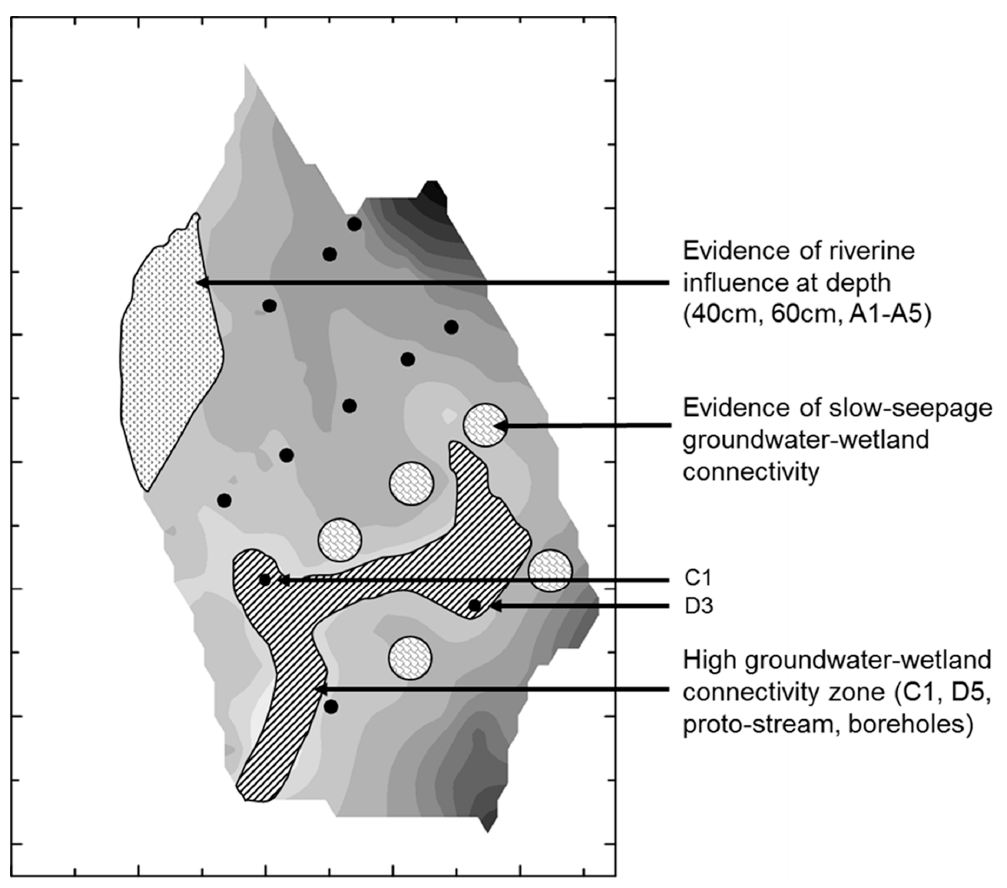
Figure 11. Conceptual model of baseflow wetland hydraulic connectivity at Boxford.